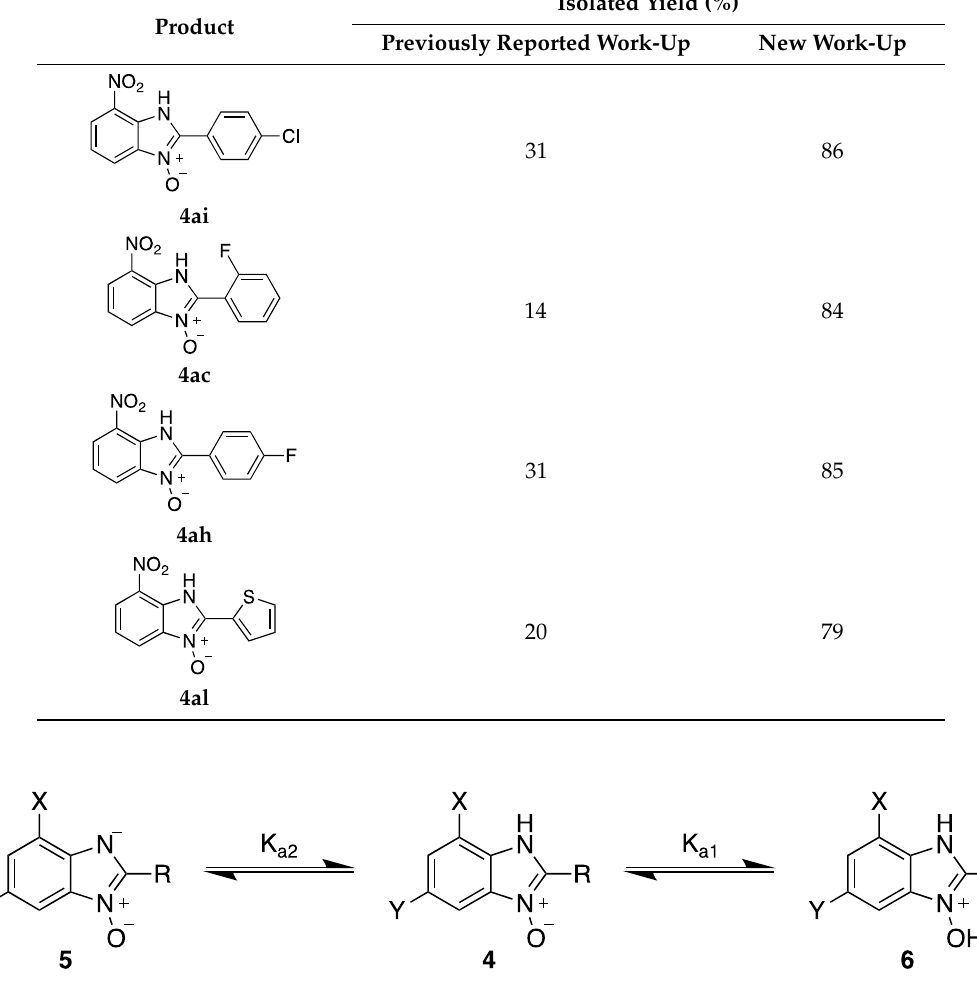
Table 1. Comparative isolated yields obtained for four representative products using the previous and improved work-up protocols.